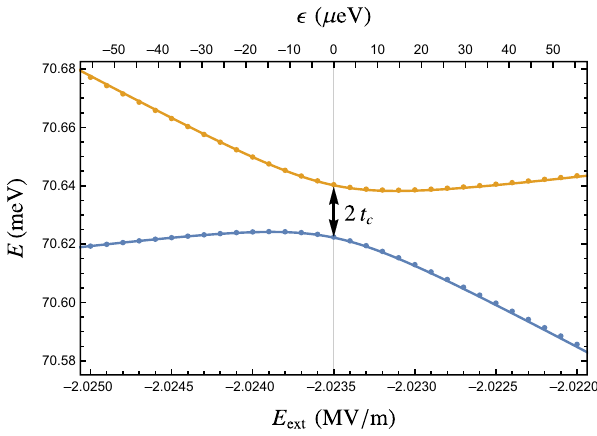
FIG. 8. Energies of the ground state and the first excited state of the QD-donor system as a function of the external electric field E ext determining the level detuning (cid:2) . The dots are obtained from numerical solutions of Eq. (A3), while the solid lines describe a simplified two-level system.